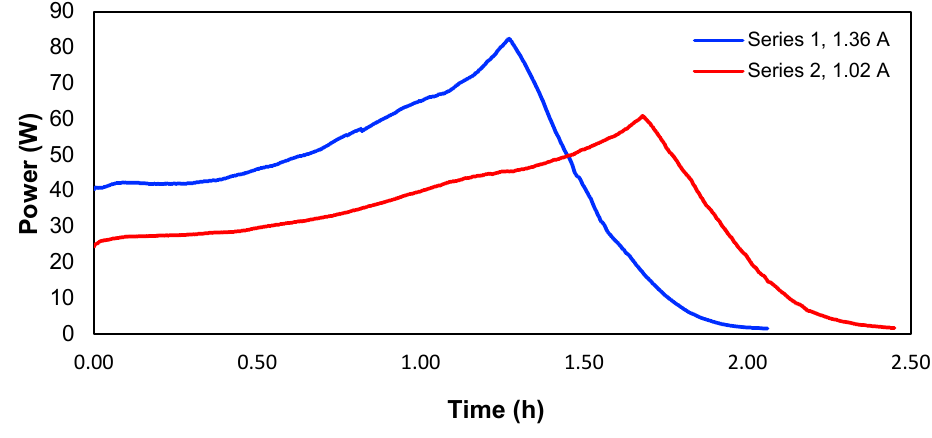
Figure 9. Power of the system over time. Table 4. Consumed energy.